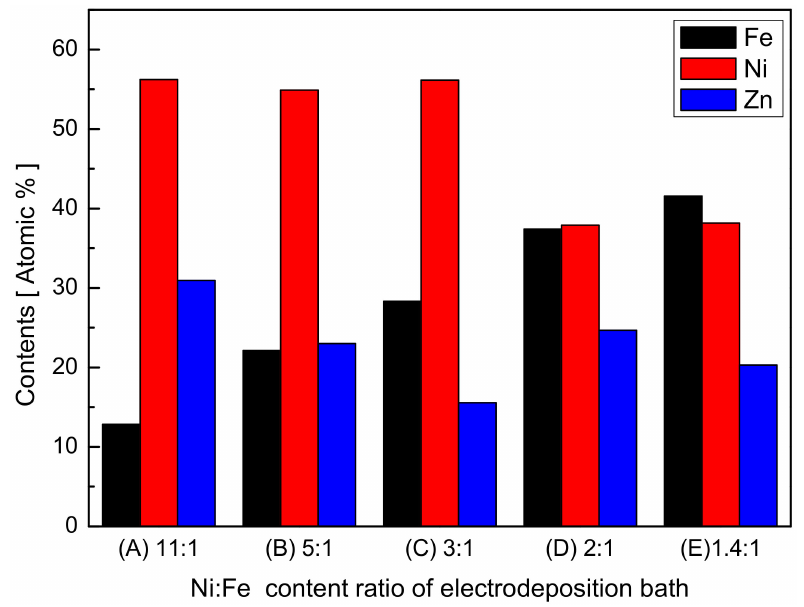
Figure 7. Surface composition after dealloying of electrodeposited Ni–Zn–Fe on Ni foam according to the Ni:Fe ratio of the bath (A), (B), (C), (D),